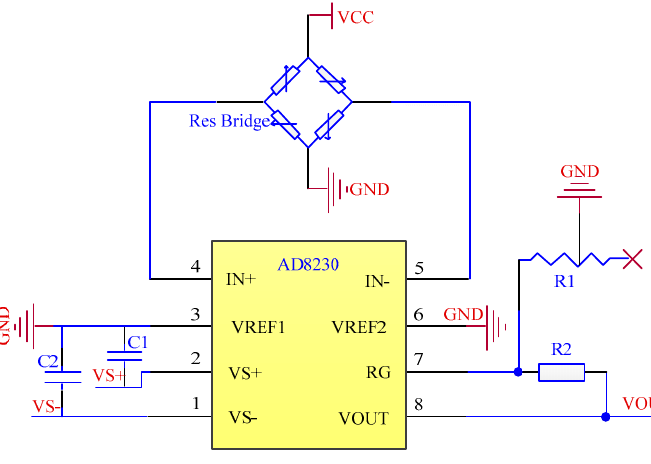
Figure 3. Circuit diagram of null drift processing.